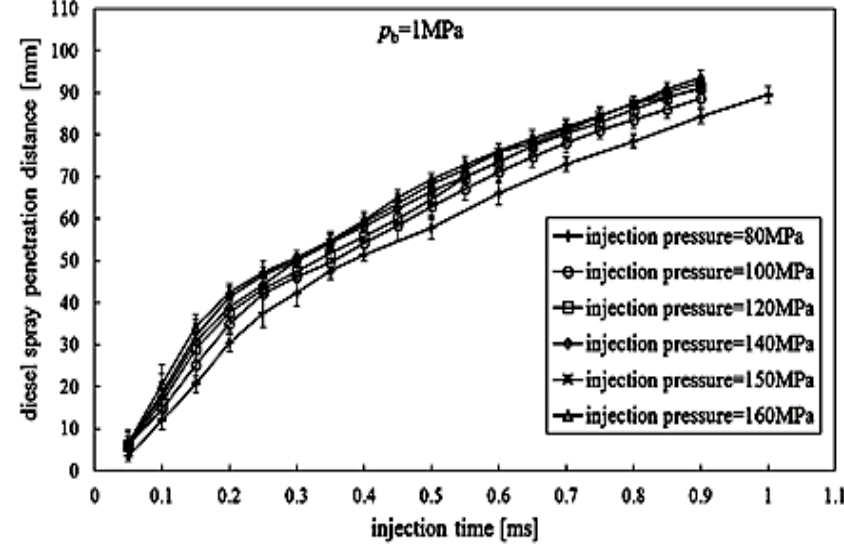
Figure 18. Diesel spray penetration, D n = 0.260 mm, ρ a = 12 kg/m 3 (at 1.0 MPa) [32].